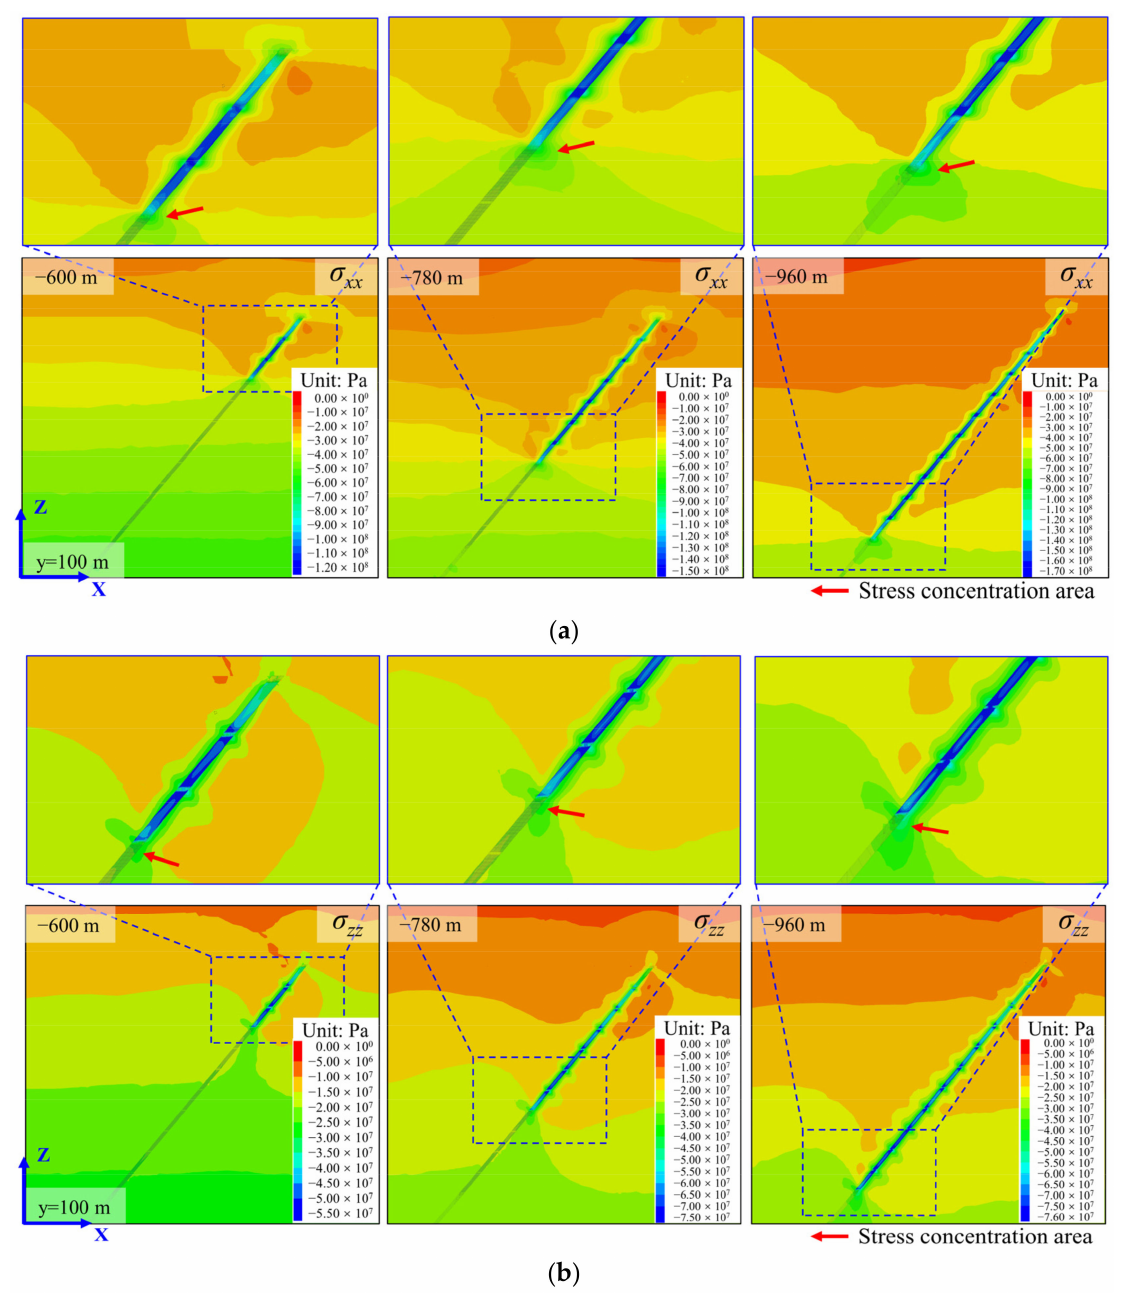
Figure 7. Stress distribution along the centre line of the barrier pillars (y = 100 m) (tensile stress is positive). ( a ) Horizontal stress distribution, σ xx ; ( b ) Vertical stress distribution, σ zz